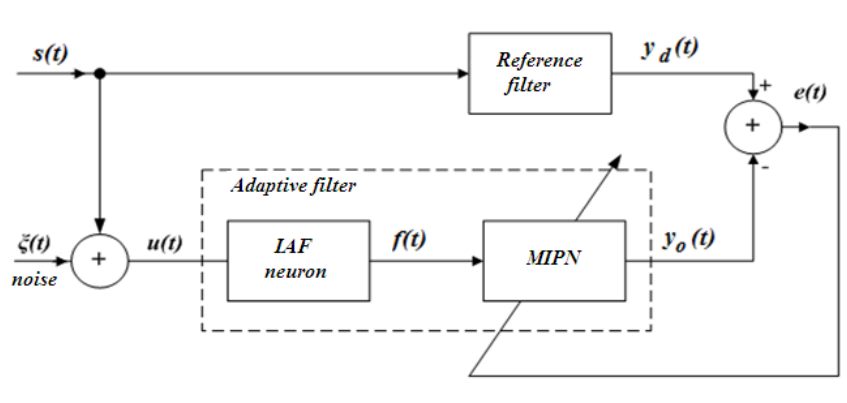
Fig. 2. The adaptive modeling